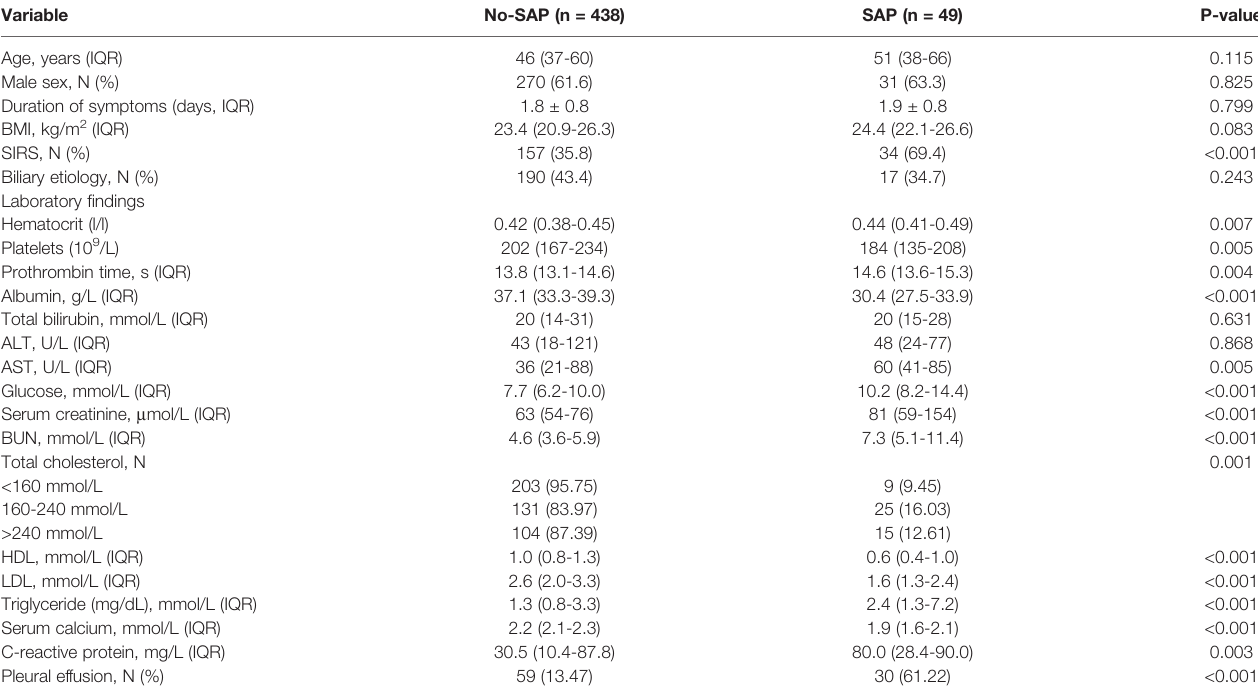
TABLE 2 | Comparison of clinical and laboratory fi ndings between patients, with and without SAP in the training sample (487 patients). Variable